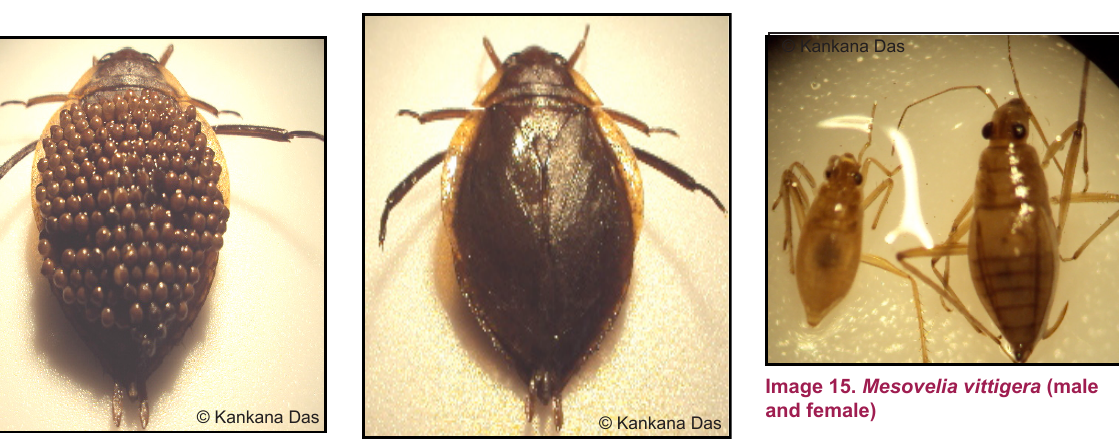
Image 10. Rhagadotarsus sp.